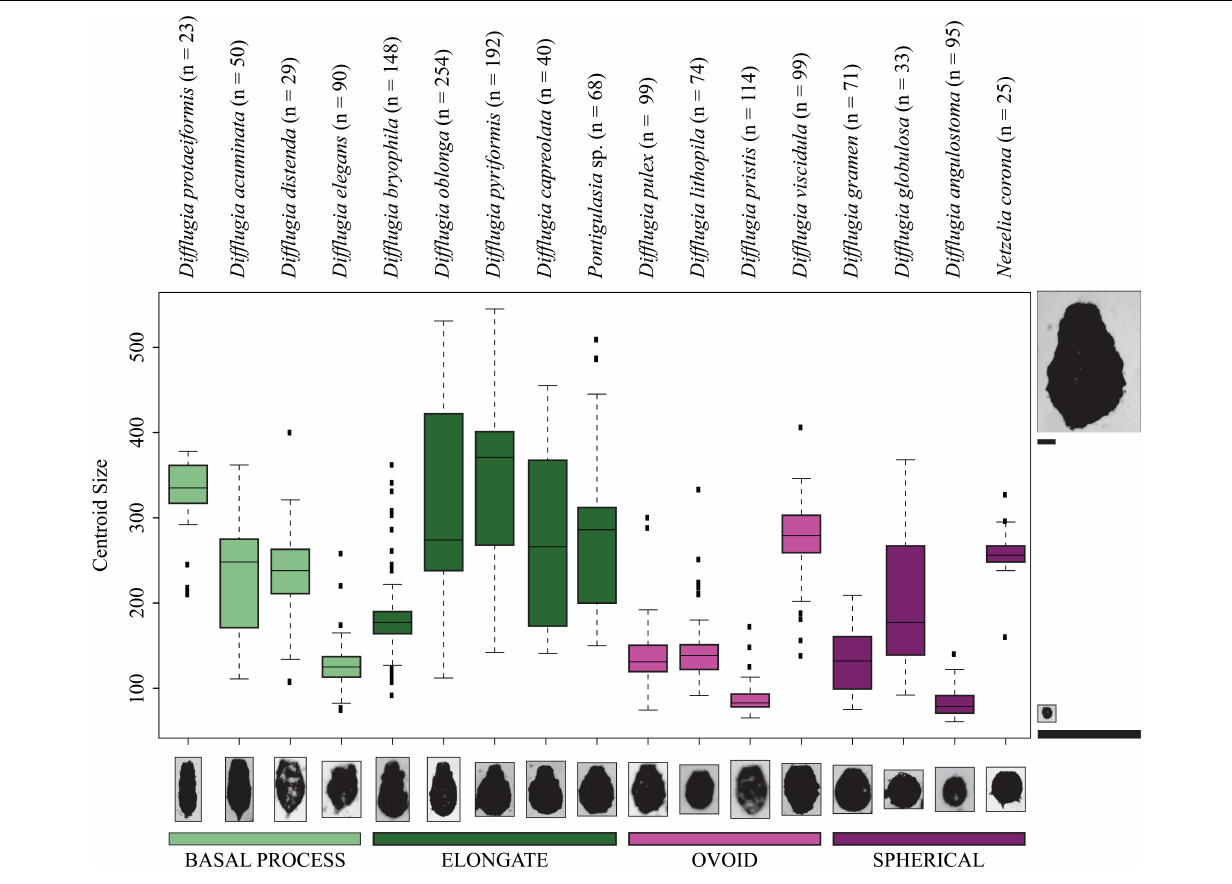
FIGURE 4 | Boxplots showing the centroid size ranges for Arcellinida taxa. Color represents shape groups. The number of specimens analyzed for each taxon is given beside the taxon name. The images to the left and right of the figure are to scale relative to one another demonstrating the difference between the maximum and minimum centroid size. The taxon images shown along the x -axis are not to